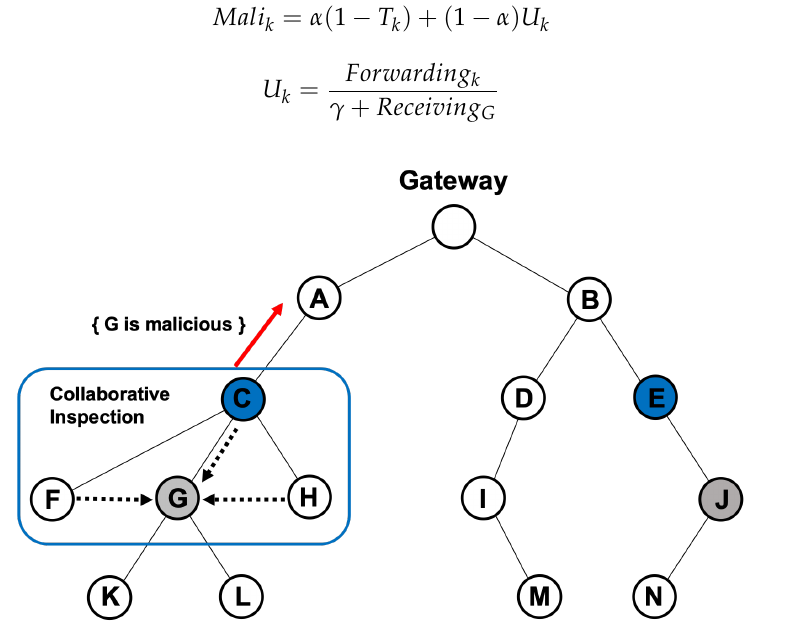
Figure 5. Example of the trust evaluation phase with the collaborative inspection